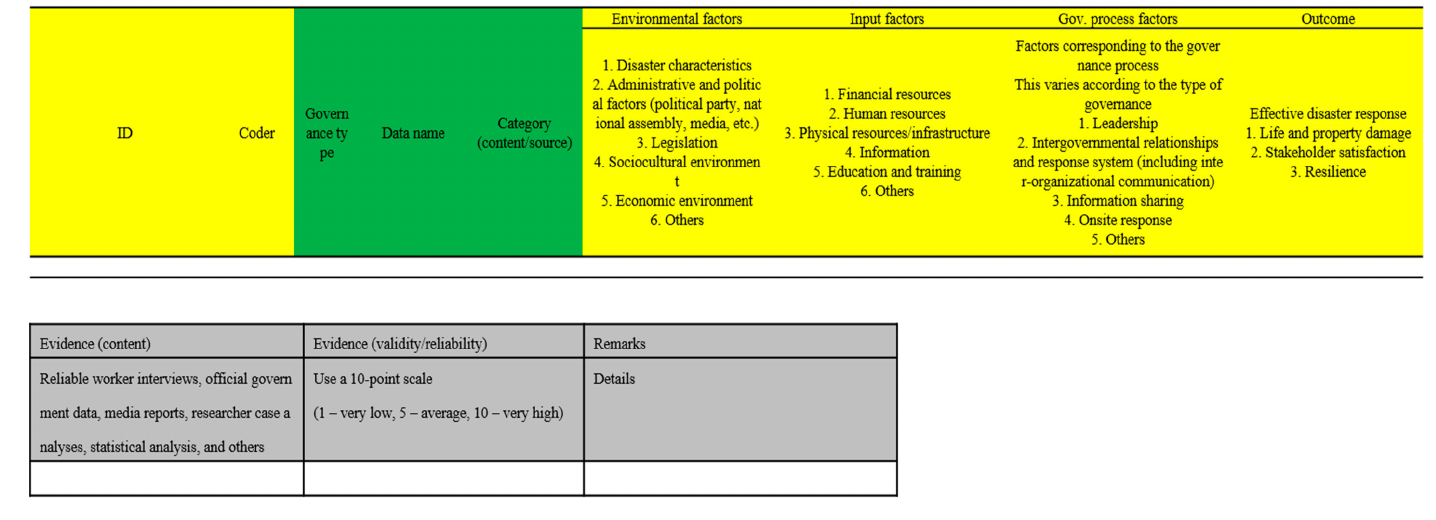
Figure 3. Coding framework. 2